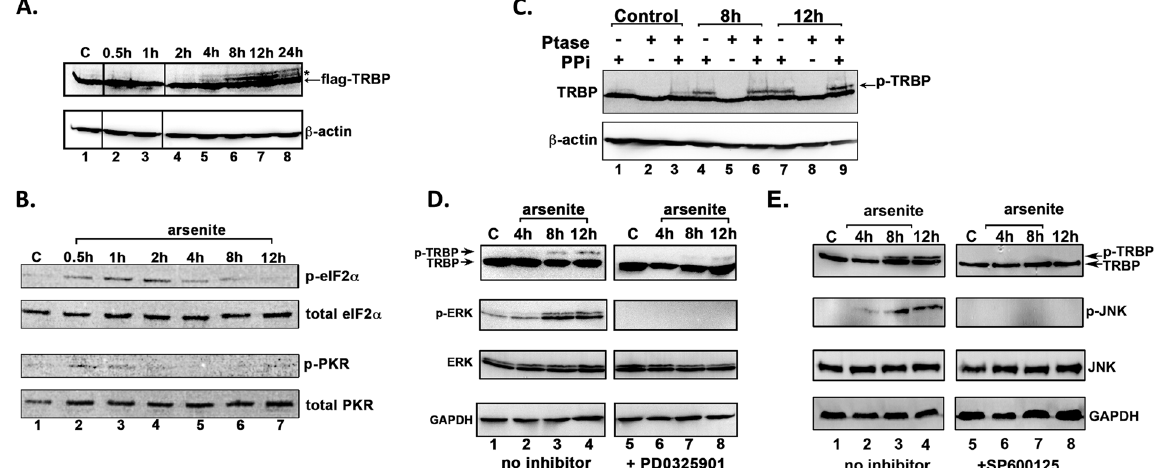
Figure 2. TRBP is phosphorylated by ERK and JNK in response to arsenite-induced oxidative stress. ( A ) TRBP’s electrophoretic mobility shifts in response to sodium arsenite treatment. A western blot analysis of 50 μ g protein per lane from HeLa-TRBP cells treated with 10 μ M sodium arsenite at the indicated time points is shown. Western blot analysis was performed with anti-Flag and anti- β actin antibodies. The slower migrating TRBP band at 8 h, and 12 h is indicated by an asterisk. The line between lanes 1 and 2 as well as between lanes 3 and 4 represents where lanes from the same western blot were joined. ( B ) PKR phosphorylation and eIF2 α phosphorylation kinetics in response to sodium arsenite treatment. HeLa cells were treated with 10 µ M sodium arsenite and cell extracts were prepared at the indicated time points. PKR and eIF2 α phosphorylation status at each time point was determined by a western blot analysis using anti-phospho-PKR and anti-phospho- eIF2 α specific antibodies using 100 µ g and 10 µ g of total protein respectively. Each blot was subsequently stripped and re-probed with anti- eIF2 α or anti-PKR antibody to ensure equal loading in all lanes. ( C ) TRBP is phosphorylated in response to oxidative stress. Extracts from untreated, and 8 h, or 12 h arsenite-treated TRBP- HeLa cells were prepared in the presence or absence of phosphatase inhibitor (PPi) as indicated above the lanes and subsequently treated with phosphatase (Ptase) or left untreated as indicated. Western blot to was performed with anti-Flag antibody followed by anti- β -actin antibody. ( D ) ERK is phosphorylated in response to oxidative stress and phosphorylates TRBP. TRBP overexpressing TRBP-HeLa cells were treated with 10 μ M arsenite alone or in combination with the MEK inhibitor PD0325901 for 24 hours. Cell extracts were made at the indicated time points, and western blot analysis was performed using anti-Flag, anti-phospho-ERK, anti-total ERK, and anti-GAPDH antibodies. ( D ) JNK is phosphorylated in response to oxidative stress and phosphorylates TRBP. TRBP overexpressing TRBP-HeLa cells were treated with 10 μ M arsenite alone or in combination with the MEK inhibitor SP600125 for 24 hours. Cell extracts were made at the indicated time points, and western blot analysis was performed using anti-Flag, anti-phospho-JNK, anti-total JNK, and anti-GAPDH